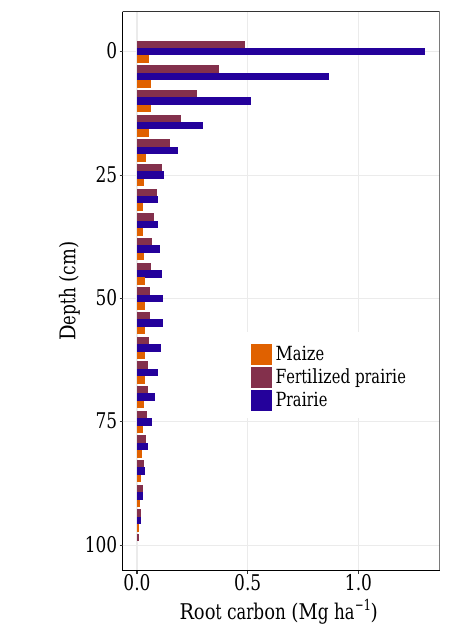
Figure 2. Absolute difference in root C pools 6 years after prairie